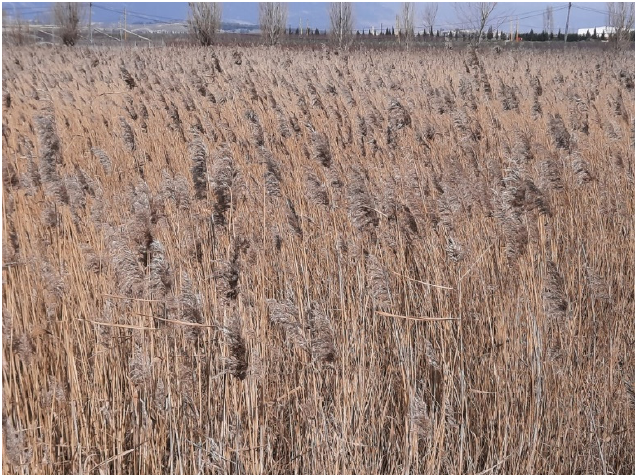
Figure 1. Phragmites australis (PA) from Bekaa Valley, Lebanon. Table 1. Properties of coarse and fine aggregates.